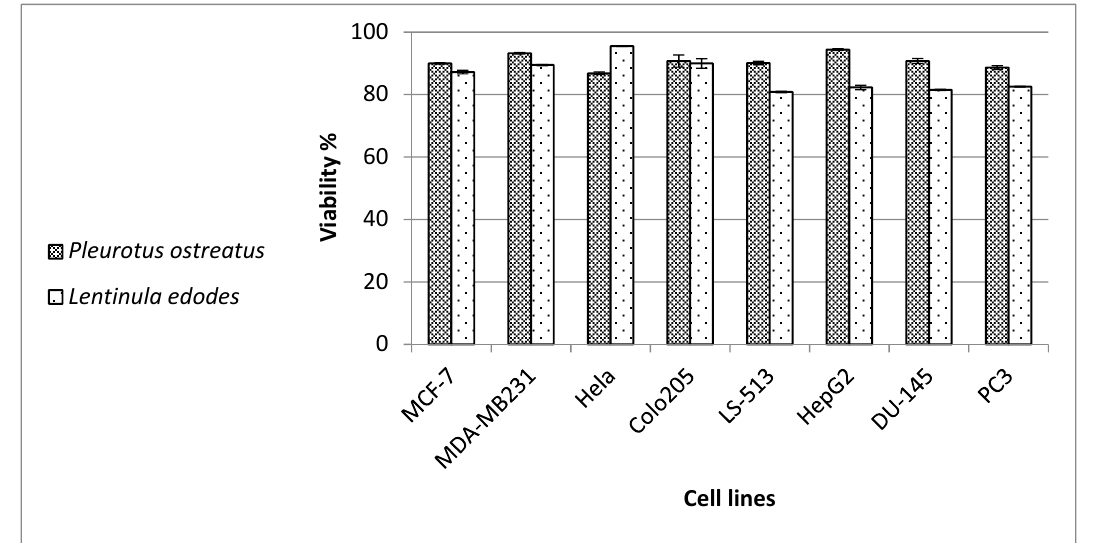
Figure 2. Cytotoxic effect of the mushroom extracts Pleurotus ostreatus and Lentinula edodes against cancer cell lines MCF-7, MDA-MBA-231, Hela, Colo-205, LS-513, HepG2, Du-145 and PC-3. Against Leukemia and Lymphoma Cell Lines Mushroom extracts of P. ostreatus and L. edodes were tested for cytotoxicity against